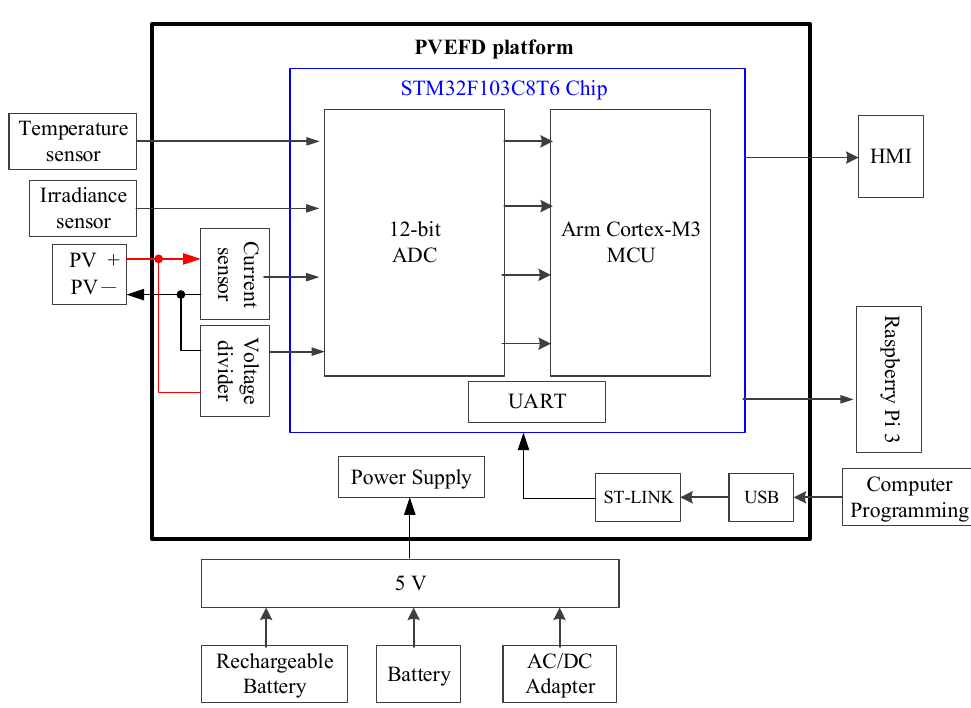
Figure 3. Schematic of proposed IoT-based PVEFD system. Table 1. Specifications of sensor devices.